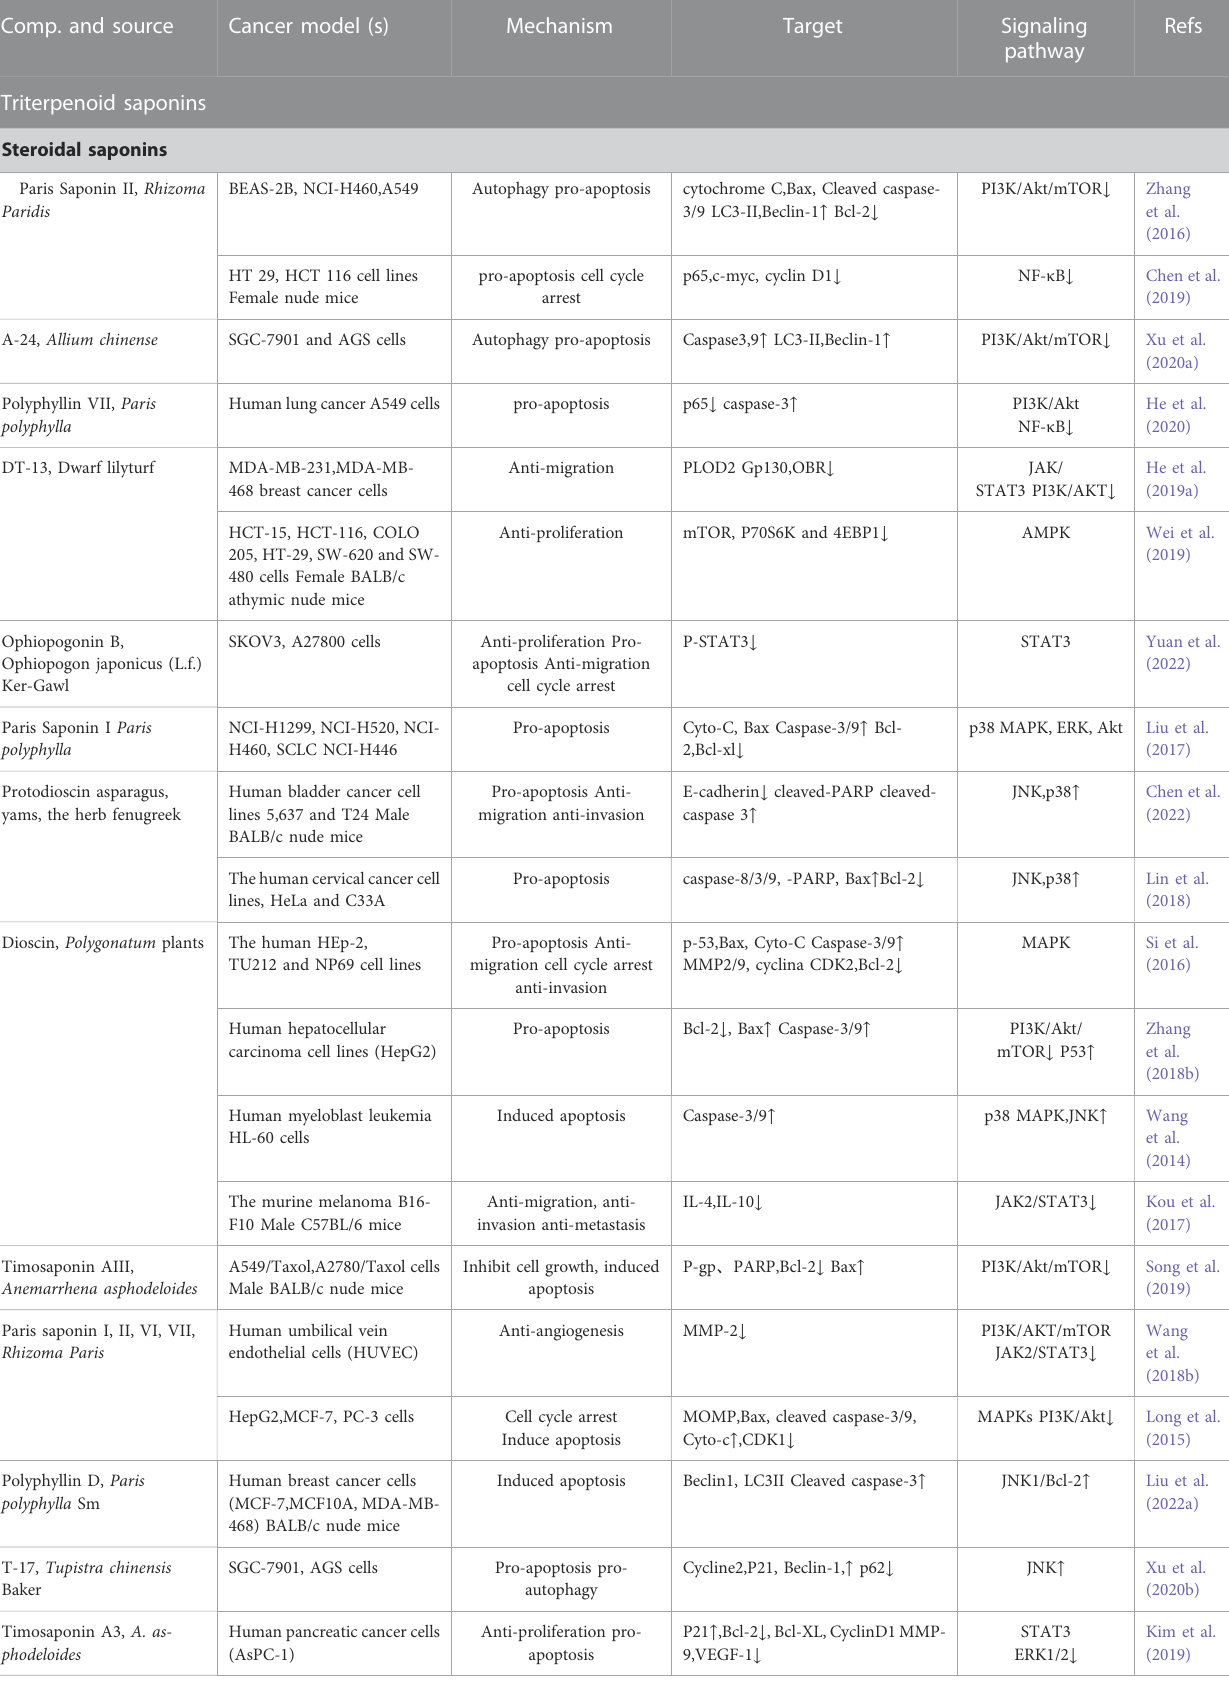
TABLE 1 ( Continued ) Monomer saponins against cerebral ischemia-reperfusion injury. Up arrows indicate upregulation, while the down arrows indicate downregulation. Comp. and